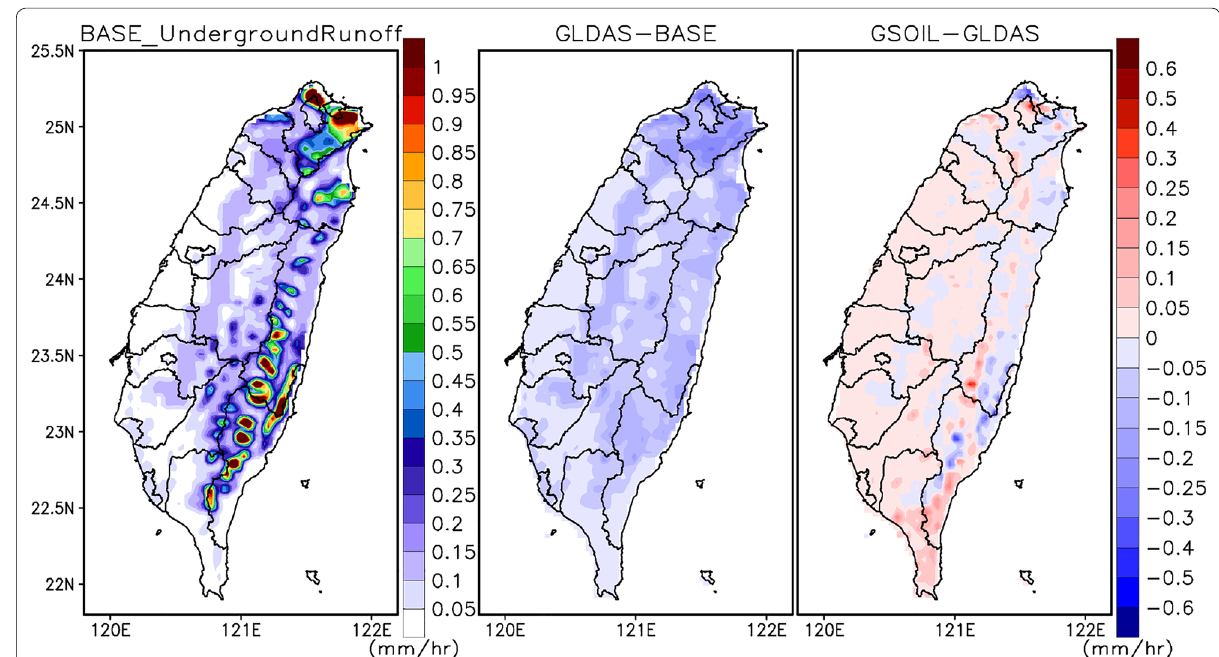
Fig. 7 Sub‑surface runoff averaged from 6‑month simulation. Left to the right are from the WRF‑base run, difference between WRF‑GLDAS and WRF‑base, and difference between WRF‑GSOIL and